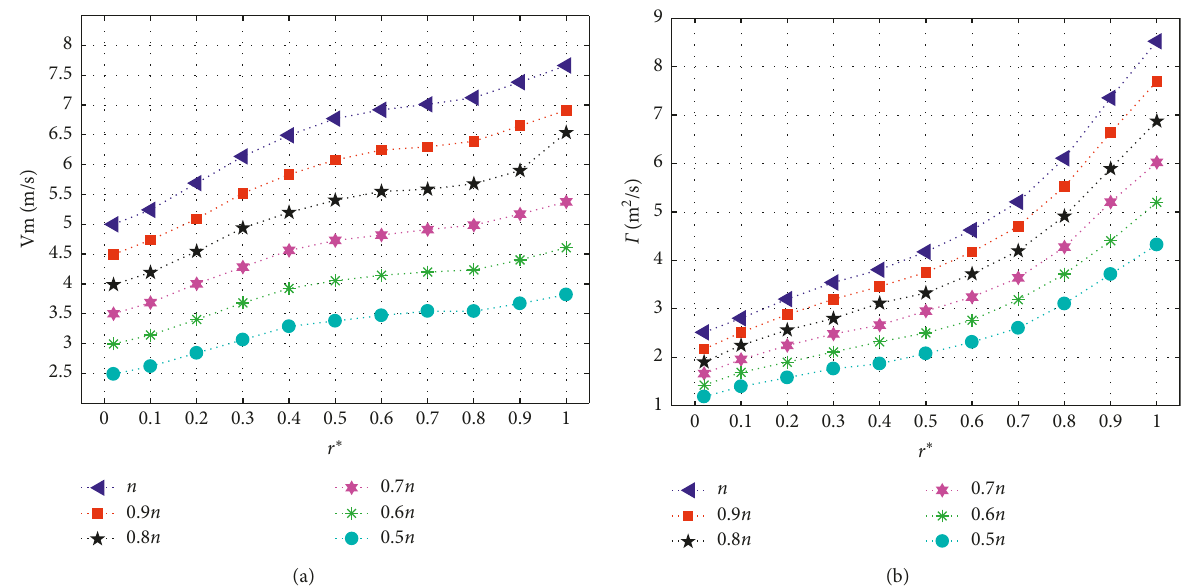
Figure 14: Velocity of the blade outlet section. (a) Axial velocity. (b) Velocity